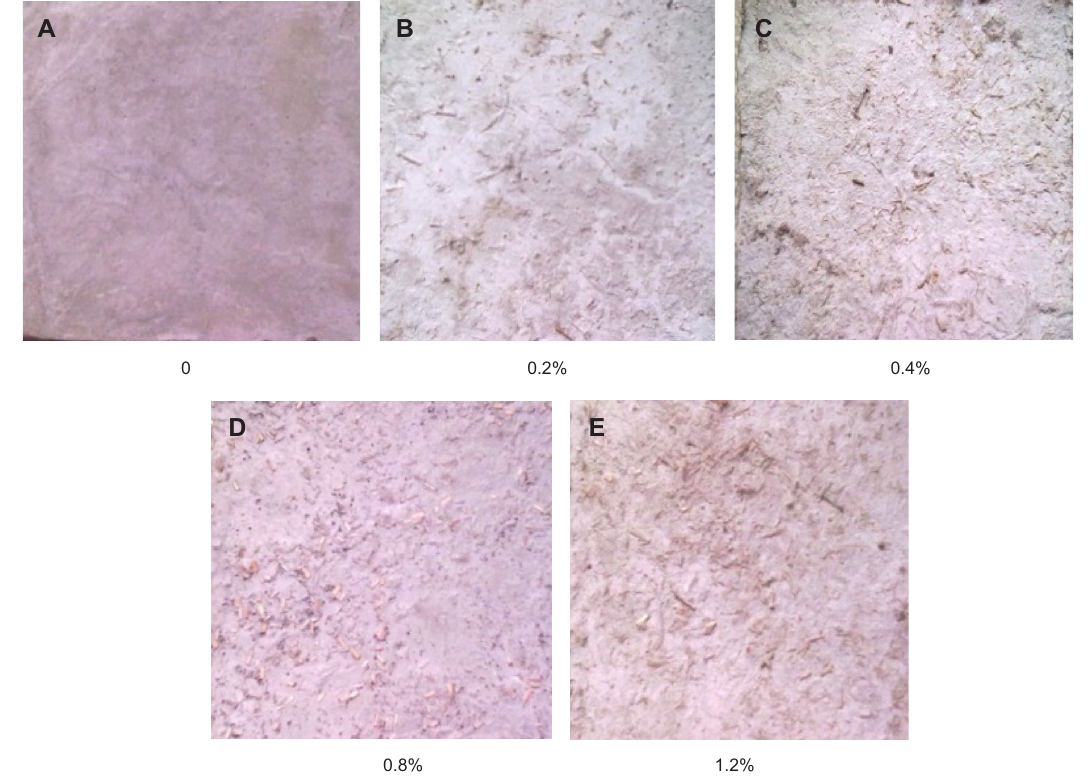
Figure 4 Appearance of mortar panels with various feather fiber contents (scaled down by